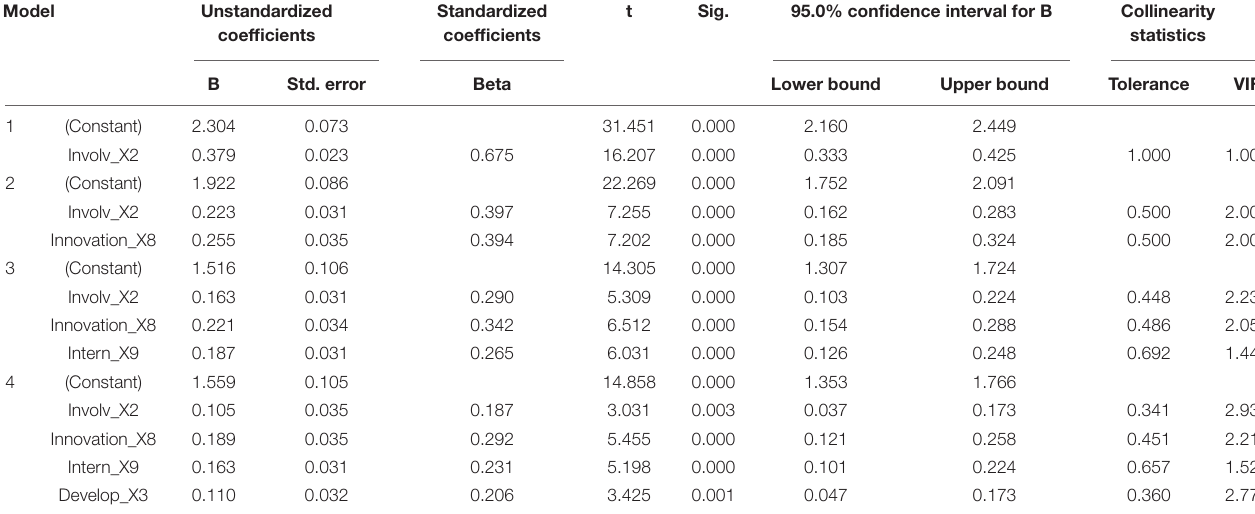
TABLE 6 | Multiple linear regression results.